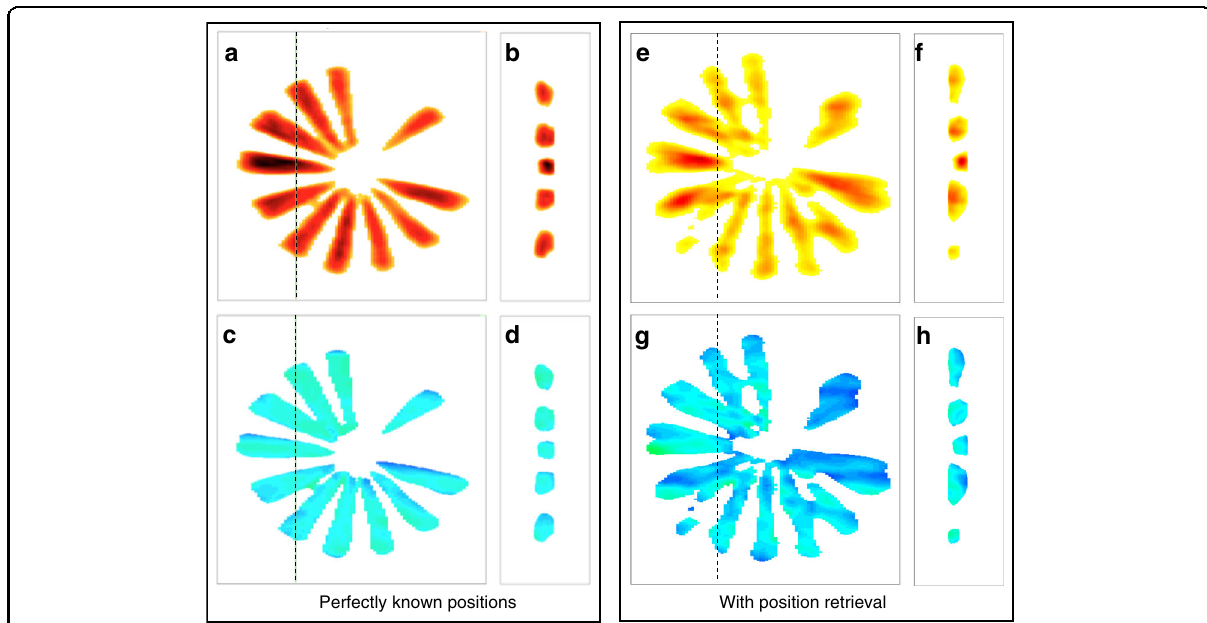
Fig. 4 Impact of the intensity level on the inversion quality (numerical study). The 3D Bragg ptychography data set was simulated with 100 times less intensity (maximum of three photons per pixel) with respect to the experimental data and poised with Poisson noise. The sample is strain- free (constant phase) and the scanning parameters are the same as the ones of the experimental data set. In a – d no spatial drift was considered (perfect setup) and a step-scan mode was introduced to generate the data. In e – h, spatial drifts and fl y-scan were introduced to generate the data and the new inversion approach was used to retrieve the object. The comparison with a – d shows a strong degradation of the image, due to the impossibility to retrieve in a satisfactory manner the object, the probe, and the sample position, as a result of a lack of information in the data set (limited intensity